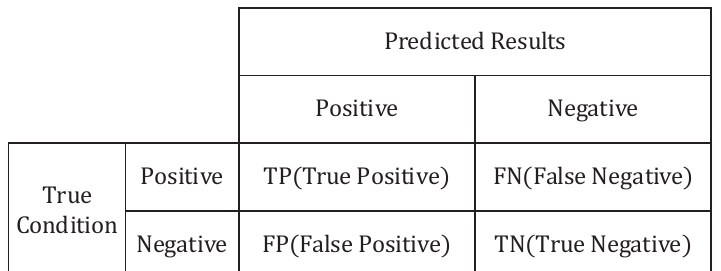
Figure 5. Confusion matrix of binary classification. The confusion matrix of multi-class classification can be reduced to several confusion matrices of binary classification.